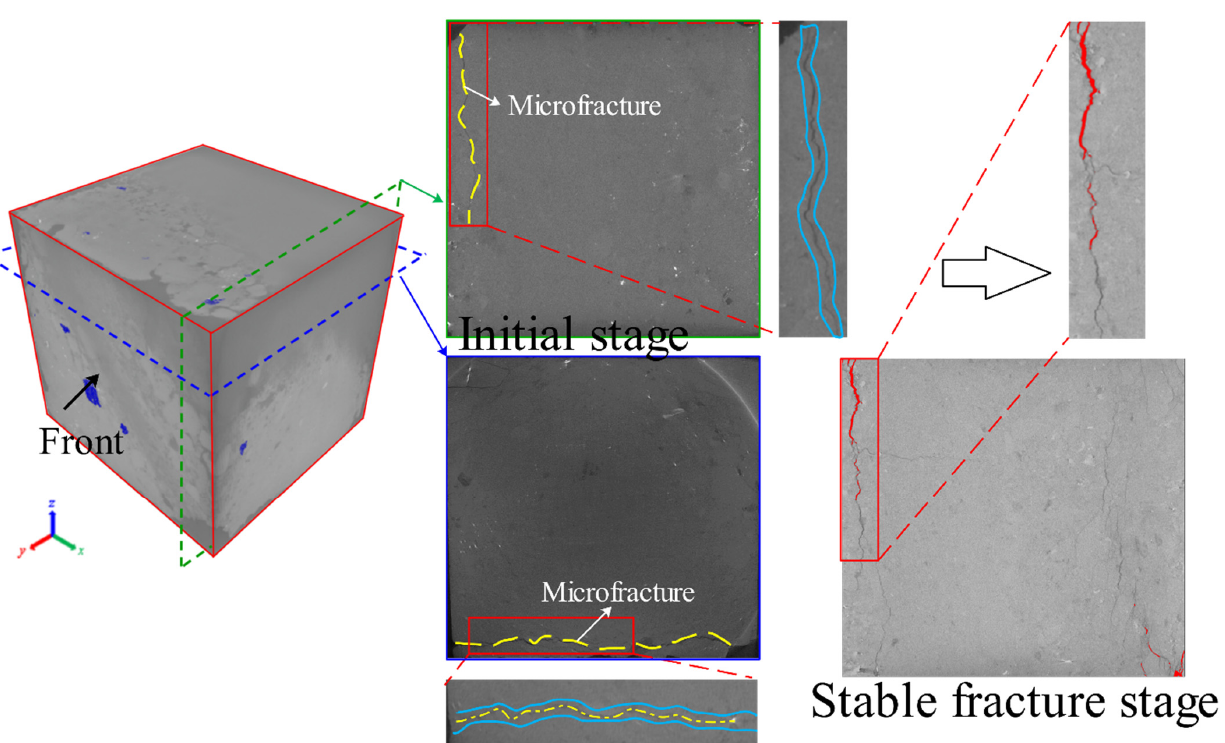
Figure 8. Schematic diagram of CT section. Extension and matching of microfractures in the initial and stable rupture stages.